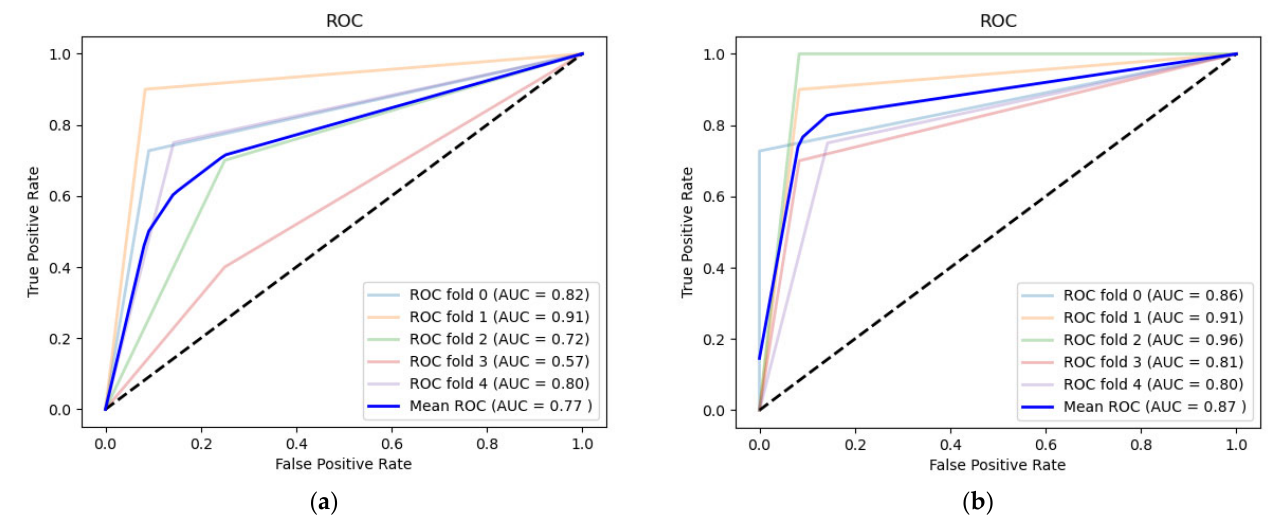
Figure 5. ROC curve of XGBoost: ( a ) non ‐ feature selection; ( b ) IG.